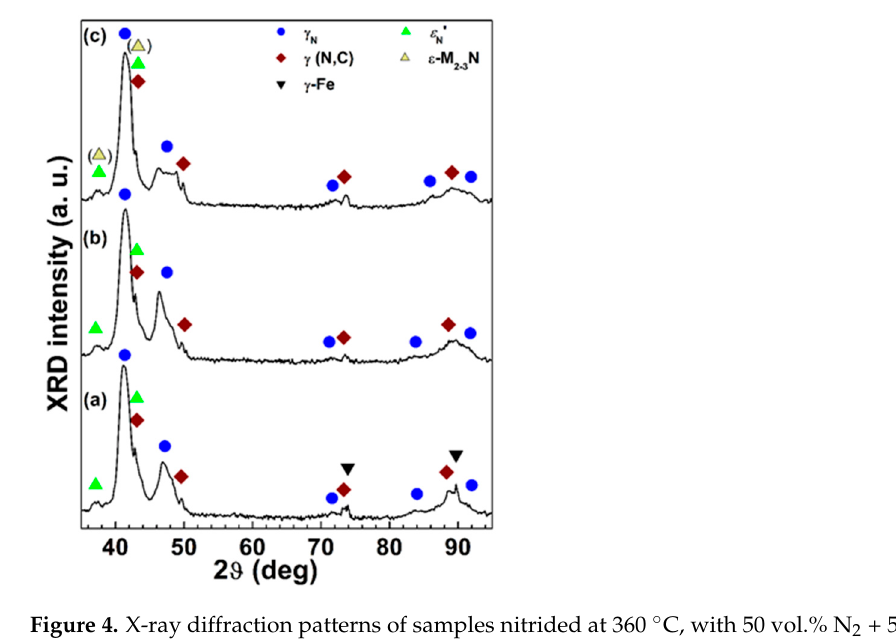
Figure 3. X-ray diffraction patterns of samples nitrided at 380 °C, for 3 h, using the following treatment atmospheres: 50 vol.% N 2 + 50 vol.% H 2 ( a ), 40 vol.% N 2 + 60 vol.% H 2 ( b ), 40 vol.% N 2 + 50 vol.% H 2 + 10 vol.% Ar ( c ), 30 vol.% N 2 + 50 vol.% H 2 + 20 vol.% Ar ( d ), 20 vol.% N 2 + 50 vol.% H 2 + 30 vol.% Ar ( e ).